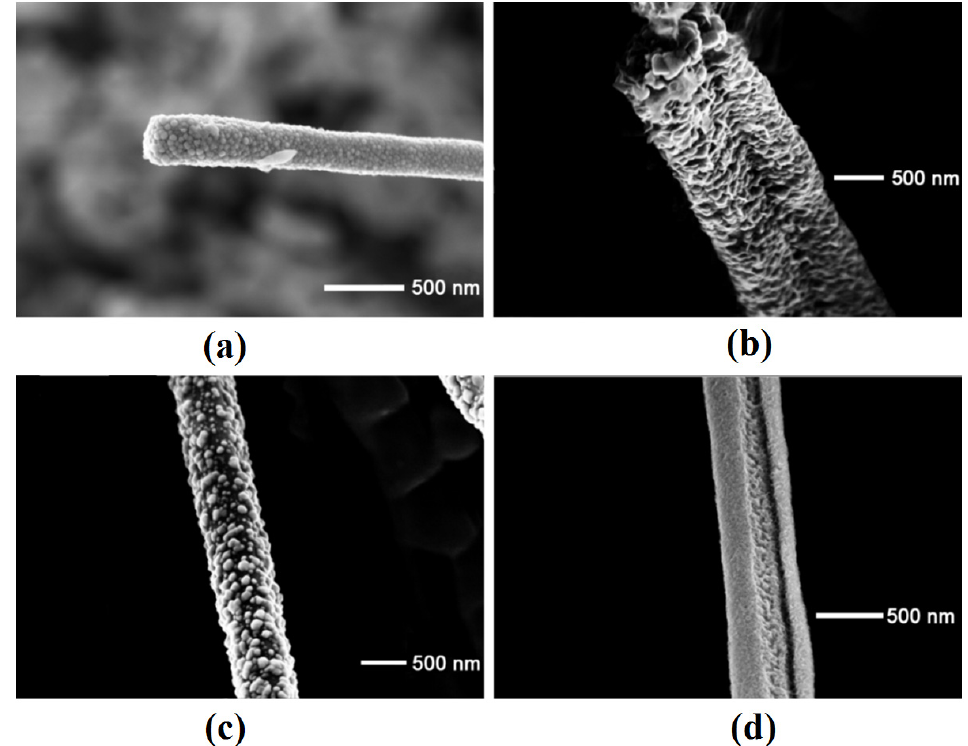
Figure 4. SEM images of electrochemically deposited Fe nanoparticles on GaAs nanowires produced on (001) GaAs after deposition for 20 s ( a ), and on GaAs nanowires produced on (111)B GaAs after deposition for 20 s ( b ), 15 s ( c ), and 10 s ( d ).